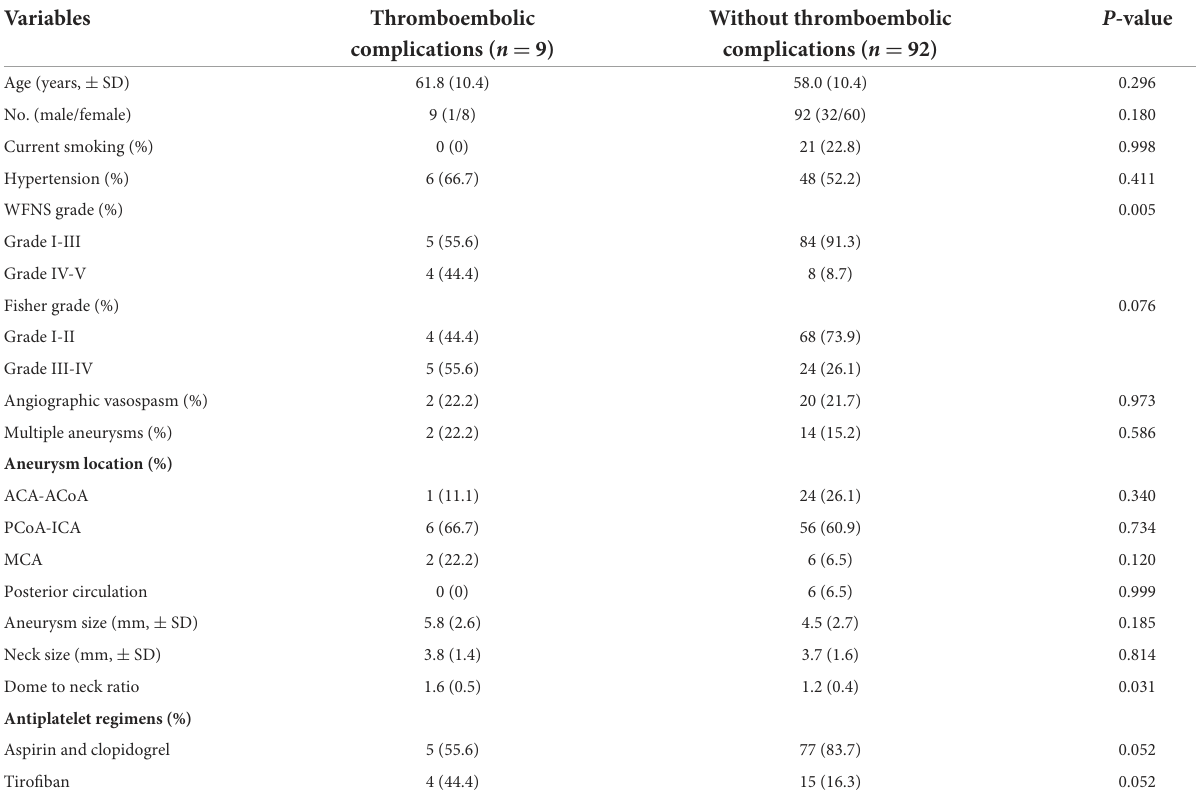
TABLE 1 Baseline characteristics between patients with thromboembolic complications and those without